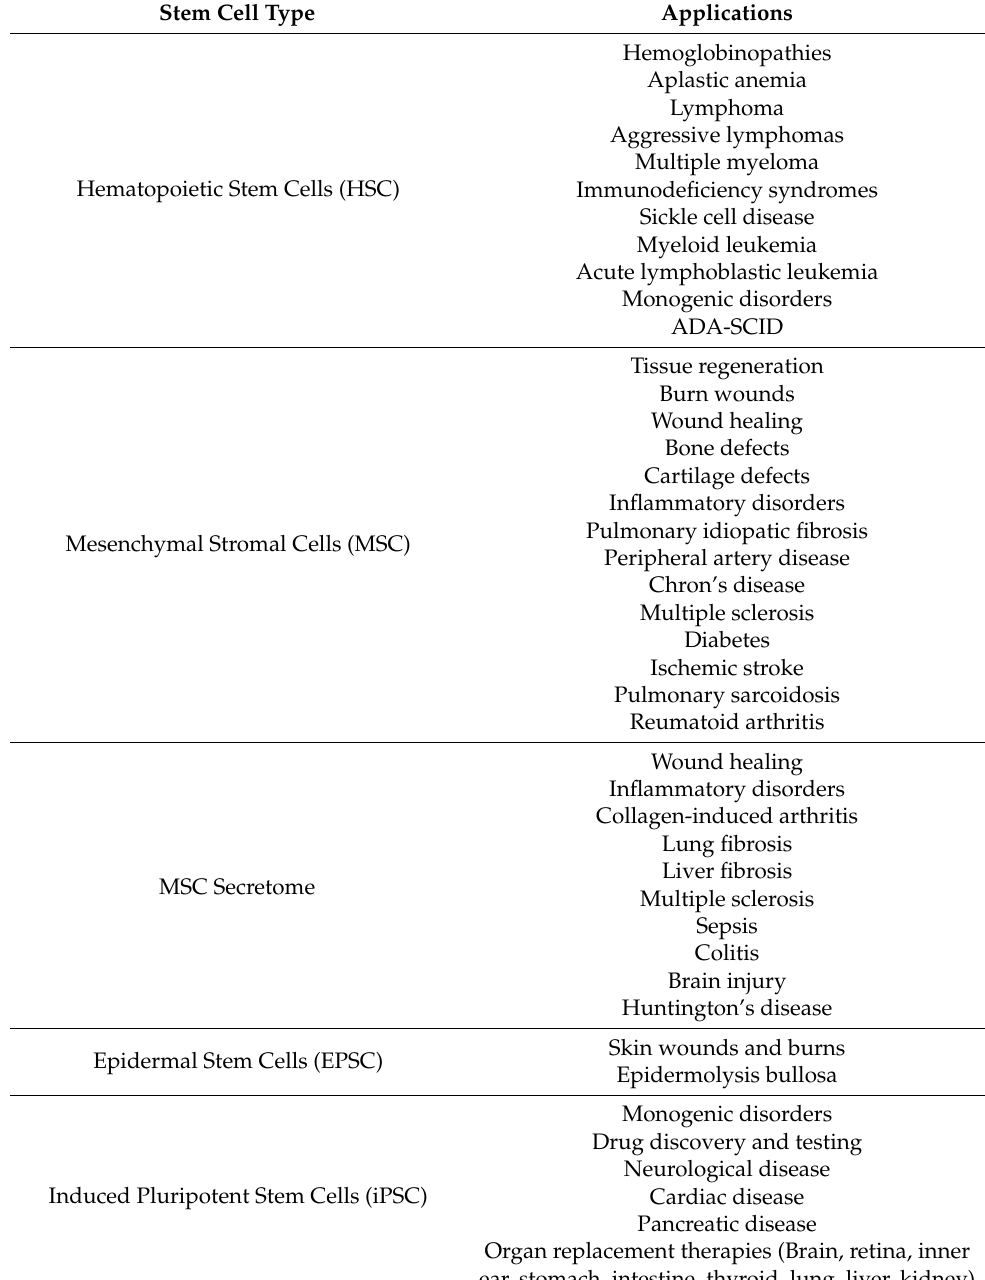
Table 1. Stem cell applications in regenerative